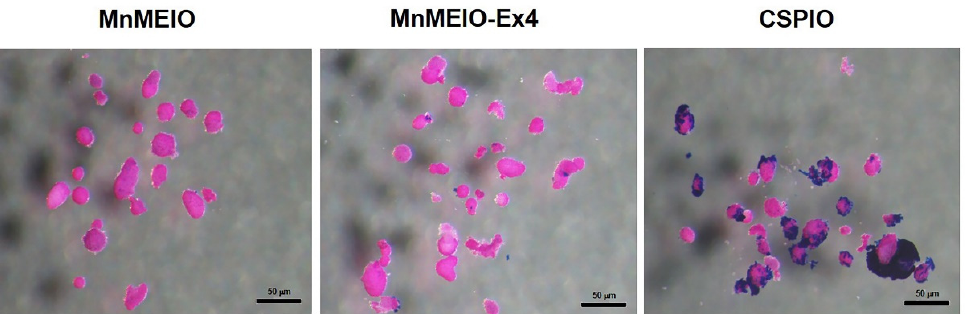
Figure 11. Binding of MnMEIO, MnMEIO-Ex4 and CSPIO NPs to islets. Islets were incubated overnight with MnMEIO NPs 40 µ g/mL, MnMEIO-Ex4 NPs 40 µ g/mL and CSPIO 10 µ g/mL, respectively, and then stained with Prussian blue.